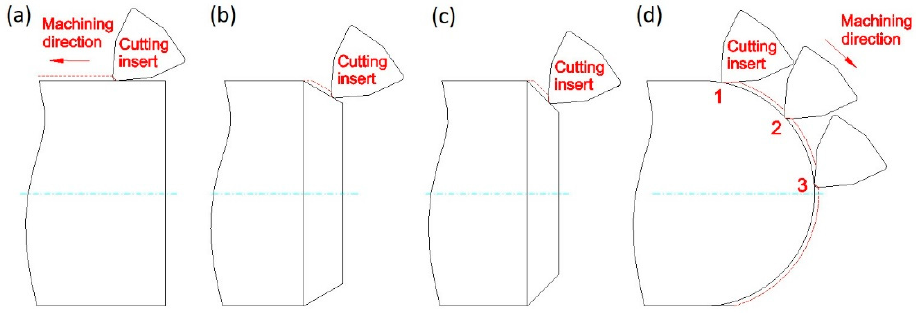
Figure 1. The scheme of machining direction for: ( a ) longitudinal turning; ( b ) taper turning 30°; ( c ) taper turning 45°; ( d ) sphere turning.